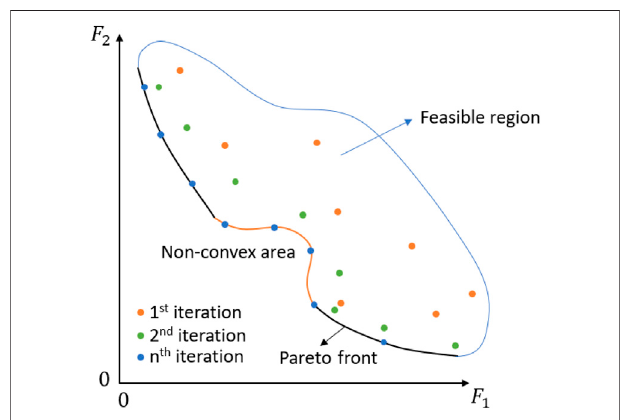
FIGURE 1 | General representation of a solving method for multi- objective optimisation problems based on an evolutionary algorithm. Both objective functions are